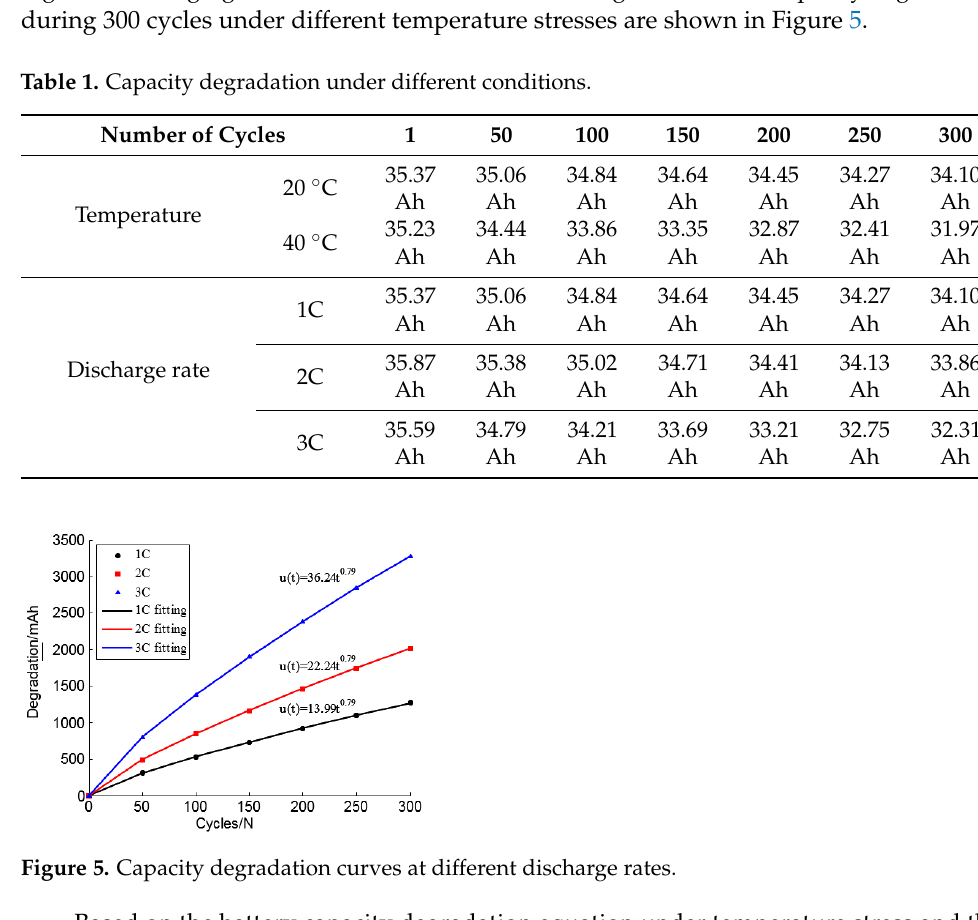
Figure 6. Recession parameter curves at different discharge rates. Figure 7. Fitting curves of capacity degradation at different temperatures. Figure 8. Current profiles of the battery for the Urban Dynamometer Driving Schedule (UDDS) test. 5.2. SOC Estimation Results To verify the accuracy of the proposed model, the LIB experiment was carried out. The LIBs were placed in a 25 °C environment, loaded with UDDS cycles. From Figure 9,